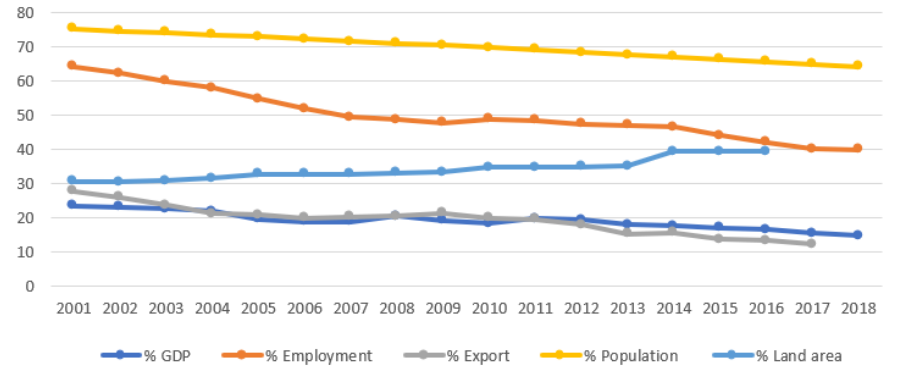
Figure 1. The proportions of the agricultural sector in the national economy. Sources: The author’s own calculation from [19–21].